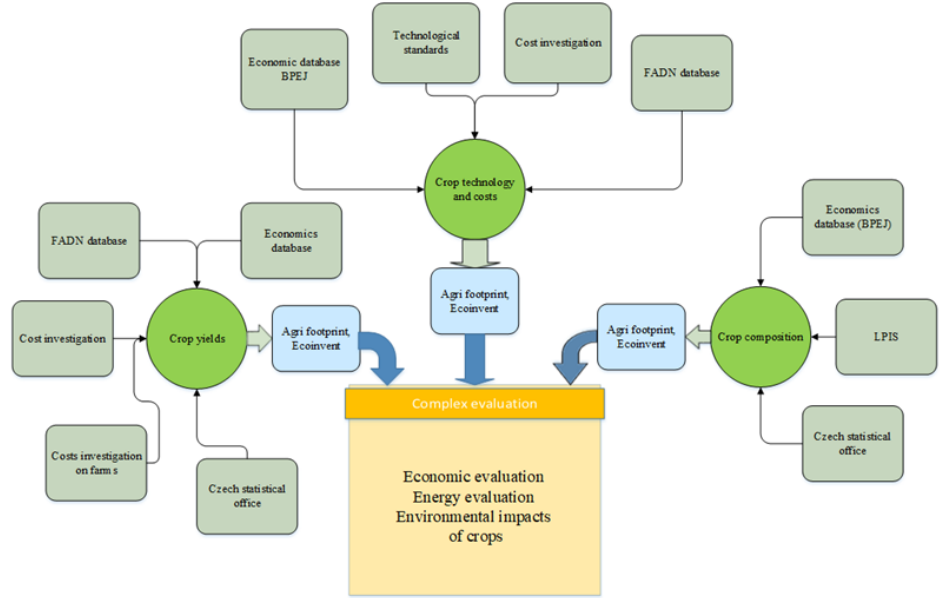
Figure A3. Sources for economic, energy and environmental data. Source: MDPI [32].